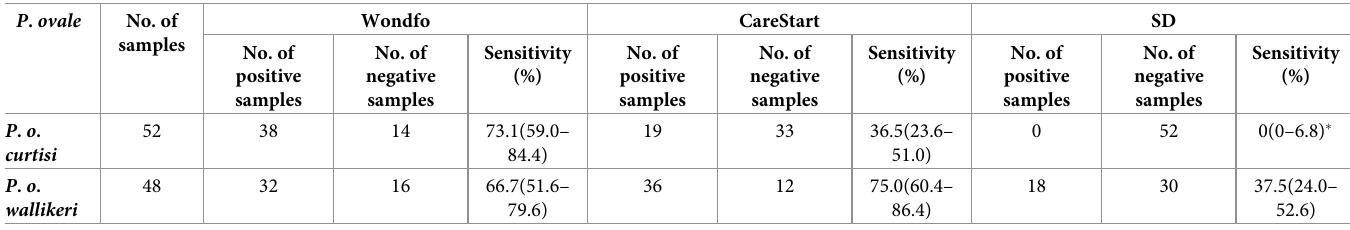
The amplified P . ovale LDH gene yielded approximately 890 base pairs, coding for 294 amino acids. A total of 100 of the amplified genes were sequenced to analyze the genetic varia- tions in the P . ovale LDH gene using Clustal W2 software. No nucleotide substitution was detected within the sequences of each subspecies compared to the reference sequences ( P . o . curtisi from GenBank (AY486058) and P . o . wallikeri from a paper by Bauffe et. al.). There were twenty-four single nucleotide polymorphisms (SNPs) between the two subspecies, and three of these SNPs were nonsynonymous mutations (S143P, N168K, I204V), which was con- sistent with the results of a previous study [20]. The sensitivity of the RDTs for P . ovale detection was associated with parasite densities The performance of each RDT was evaluated according to parasite density levels. Based on P . ovale parasite densities, the 100 samples were divided into three groups. For the Wondfo Pf/ Pan device, the sensitivity for cases with parasite densities greater than 500 parasites/ μ L (75.4% and 75%) was higher than that for cases with densities lower than 500 parasites/ μ L (27.3%), and this difference was statistically significant ( χ 2 = 10.75, P < 0.05, Fisher’s exact = 0.007). However, for the SD Pf/Pan device, regardless of parasite density, the sensitivity was less than 50%, and the cases with parasite densities lower than 500 parasites/ μ L could not be detected with this device and a significant difference was observed ( χ 2 = 26.76, P < 0.0001, Fisher’s exact < 0.0001). The sensitivity of the CareStart Pan device reached 78.1% for only those cases that had parasite densities greater than 5000 parasites/ μ L, and a significant difference was observed ( χ 2 = 10.49, P = 0.005, Fisher’s exact = 0.005) (Table 4). The sensitivity of pLDH-based RDTs for P . ovale detection was correlated with pLDH concentration To determine the relationship between pLDH concentration and the sensitivity of the three RDTs for P . ovale detection, the P . ovale samples were divided into three groups according to Table 3. Comparison of the sensitivity of the three RDTs in the detection of P . ovale curtisi and P . ovale wallikeri . P . ovale No. of